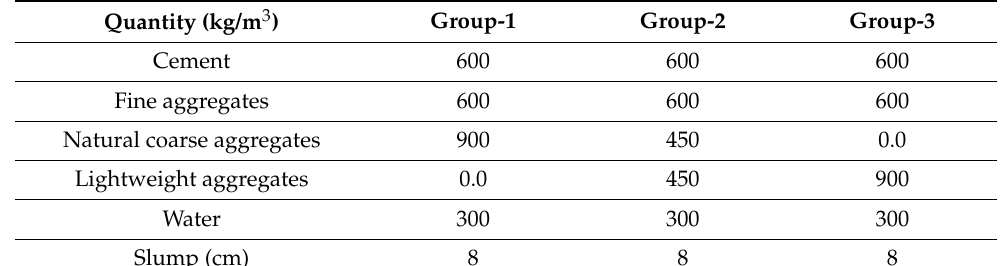
Table 2. Concrete mix proportions.